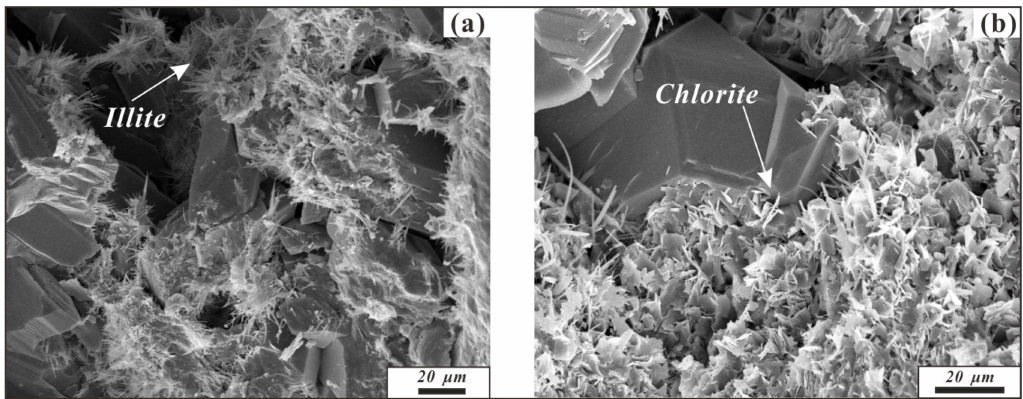
Figure 8. SEM images of illite-associated micro-intergranular pores ( a ) and slit pores among schistose layers of acicular chlorite ( b